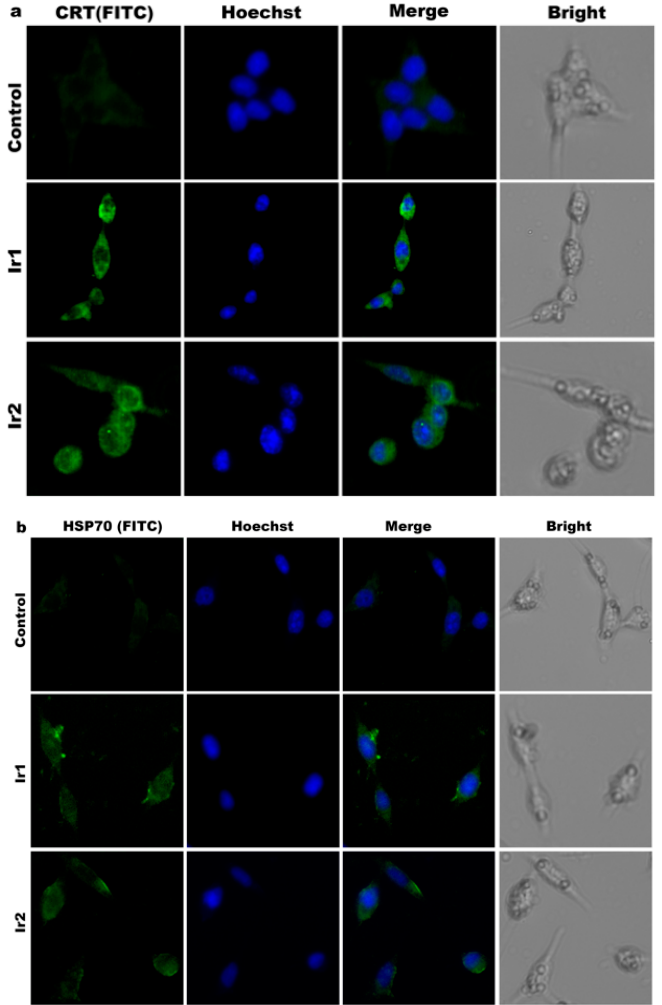
Figure 14. The assays of intracellular CRT ( a ) and HSP70 ( b ) content after a 24 h exposure of HCT116 cells to IC 50 concentration of Ir1 and Ir2